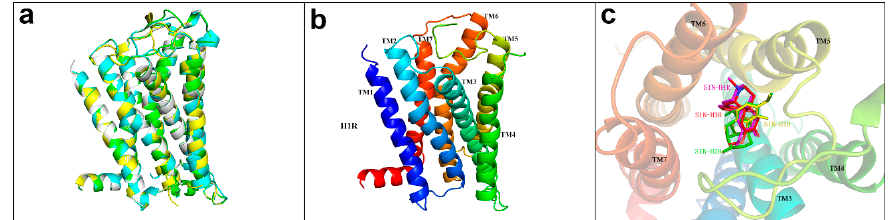
Figure 2. ( a ) Superimposed charts of histamine receptor protein structure, with H1R-white, H2R-green, H3R-blue, and H4R-yellow; ( b ) 7 transmembrane domains of H1R, with TM1-blue, TM2-marine, TM3-cyan, TM4-green, TM5-yellow, TM6-orange, TM7-red; ( c ) binding mode diagram of SIN and four target proteins using ball-and-stick model: H1R-yellow, H2R-green, H3R-red, H4R-magenta.